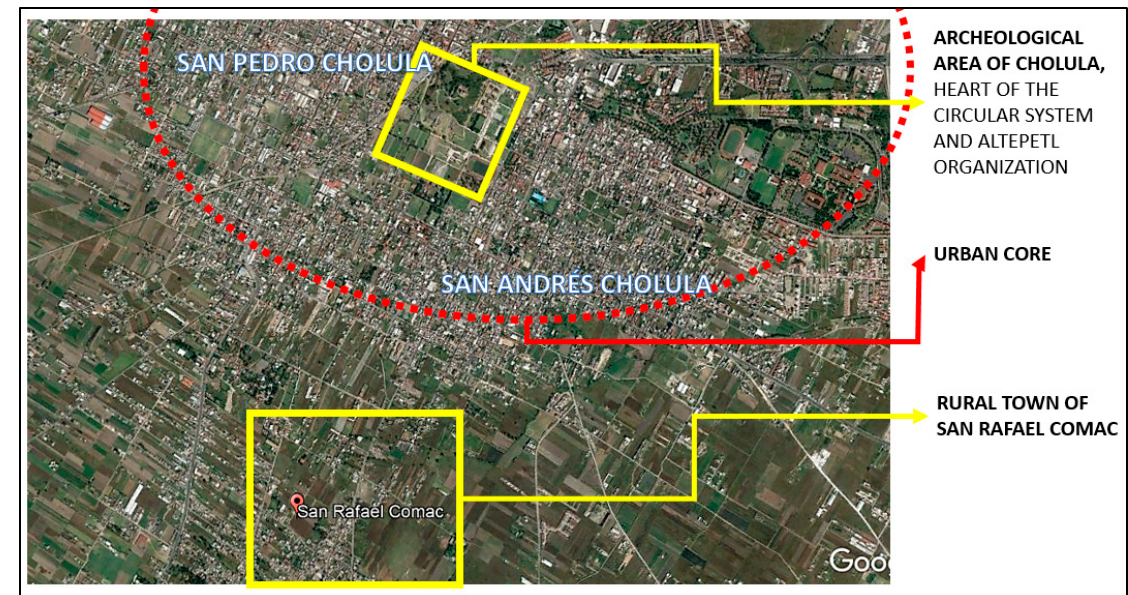
Figure 1. Territorial location of San Andrés Cholula and San Rafael Comac. Source: Google Earth (2017).